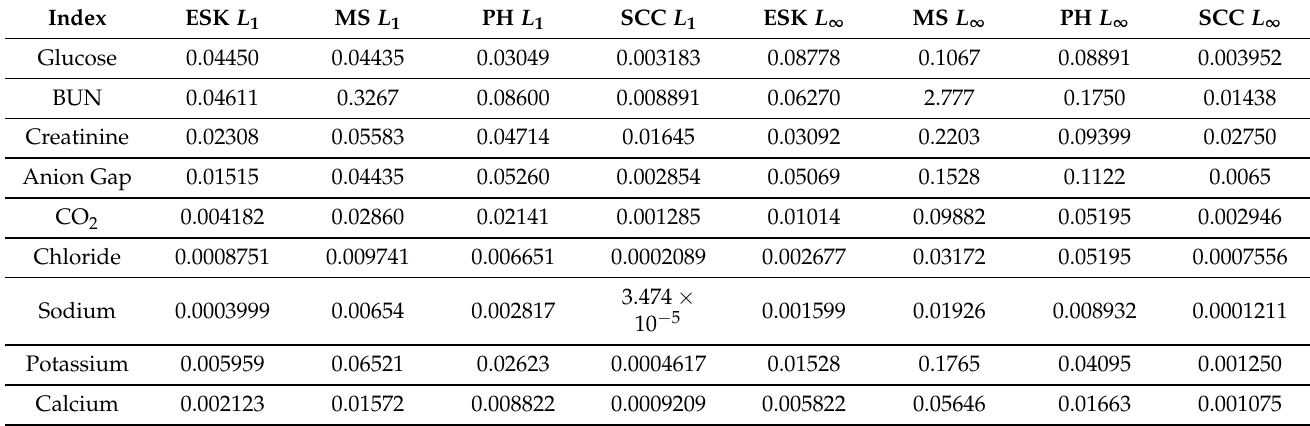
Table 7. Relative L 1 and L ∞ errors for all 9 indices of the patients.